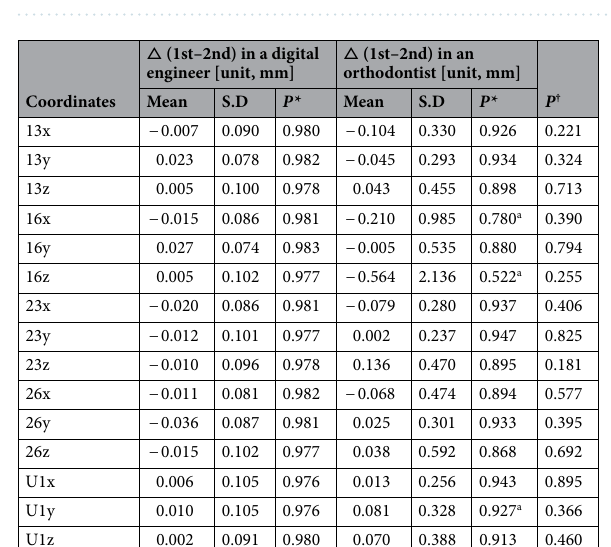
Figure 1. An example of Bland–Altman plot of the x, y, z coordinates of #26 between the first and second registration of maxillary digital cast image and facial CBCT. ( a ) Digital engineer, ( b ) Orthodontist.